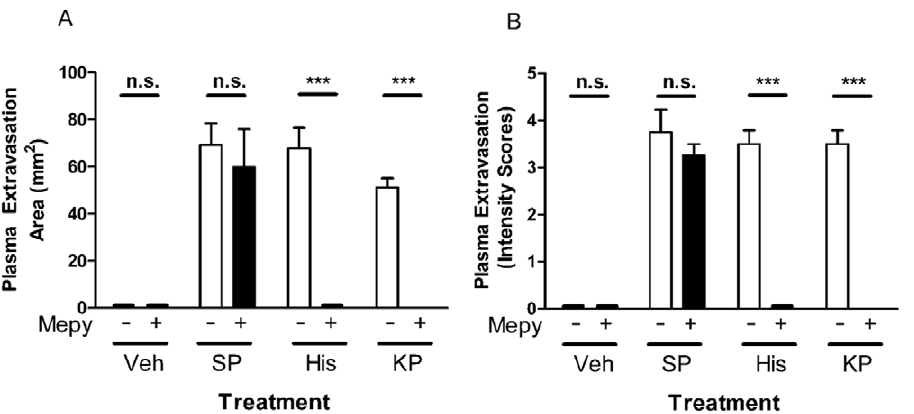
Figure 3. Mepyramine inhibits Kp-10 induced oedema formation. Female CD1 mice were anaesthetised, injected with Evans Blue i.v., and then exposed intradermally to saline (Veh), 20nmol Histamine (His), 300pmol substance P (SP) and 10nmol Kp-10 (KP) + / 2 5nmol Mepyramine (Mepy) for 15 minutes. Mice were then killed, dorsal skin removed and the oedema area measured (A). Lesion colour intensity was also assessed (B). Co- treatment with saline is indicated by white bars and co-treatment with mepyramine is indicated by black bars. Results shown as mean area (mm 2 ) 6 SEM, N =4. n.s.=no significant difference between treatments, ***=p # 0.001 between mepyramine untreated and treated groups as assessed by two way ANOVA.